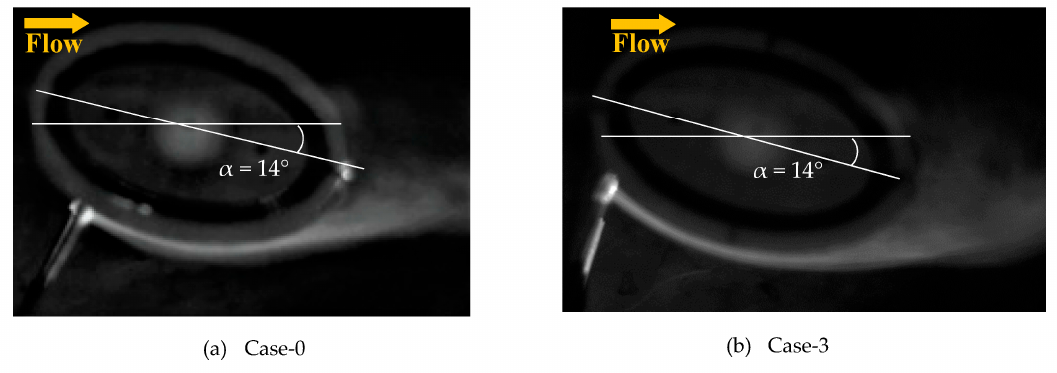
Figure 11. Smoke-wire flow visualization around lower surface of test model ( α = 14°, Re = 1.0 × 10 5